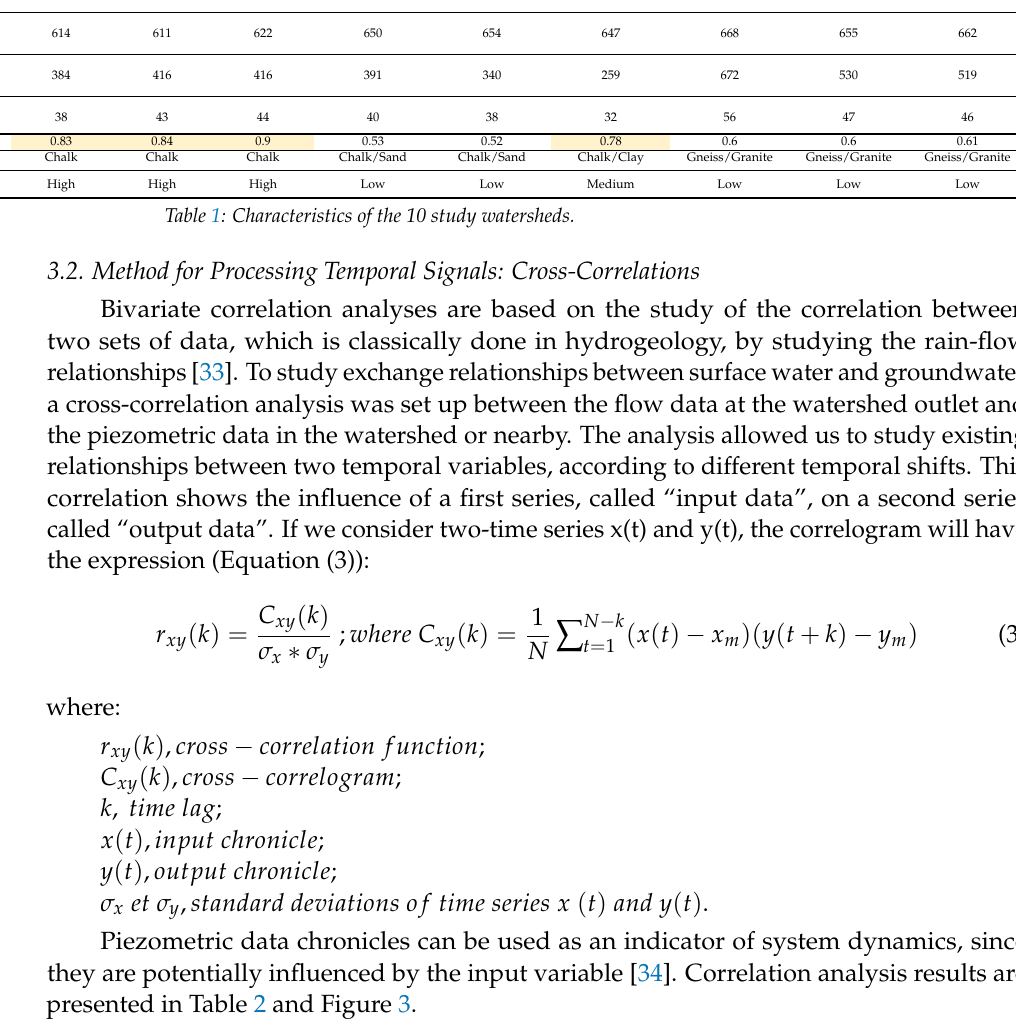
Table 1. Different geographical and hydroclimatic characteristics determined at study watersheds.